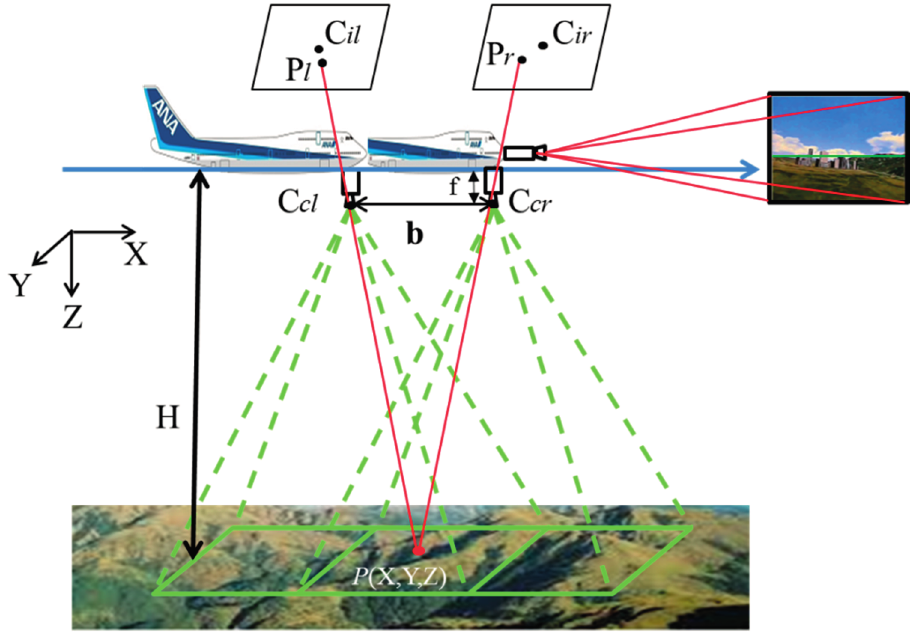
Figure 5. Relative altitude calculation with a single